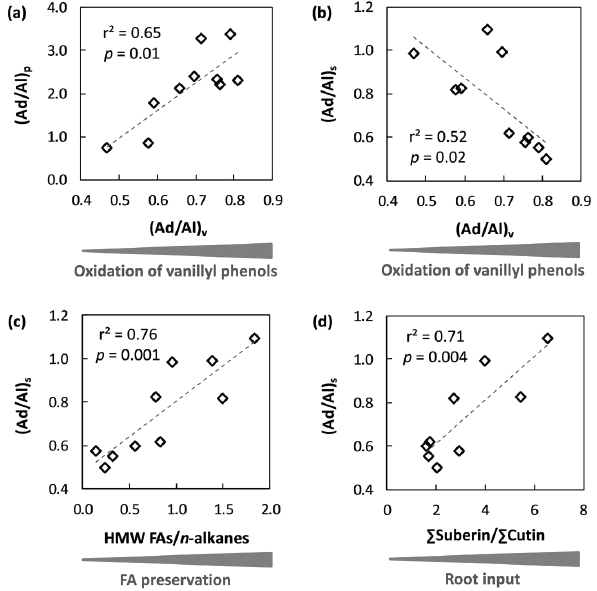
Figure 7. Relationships between the acid-to-aldehyde (Ad/Al) ra- tios and other OC parameters. Ratios of (Ad/Al) v , HMW FAs/ n - alkanes and P Suberin/ P Cutin increase with increasing oxidation of vanillyl phenols, FA preservation and root inputs, respectively. Refer to Table 3 for abbreviations and detailed